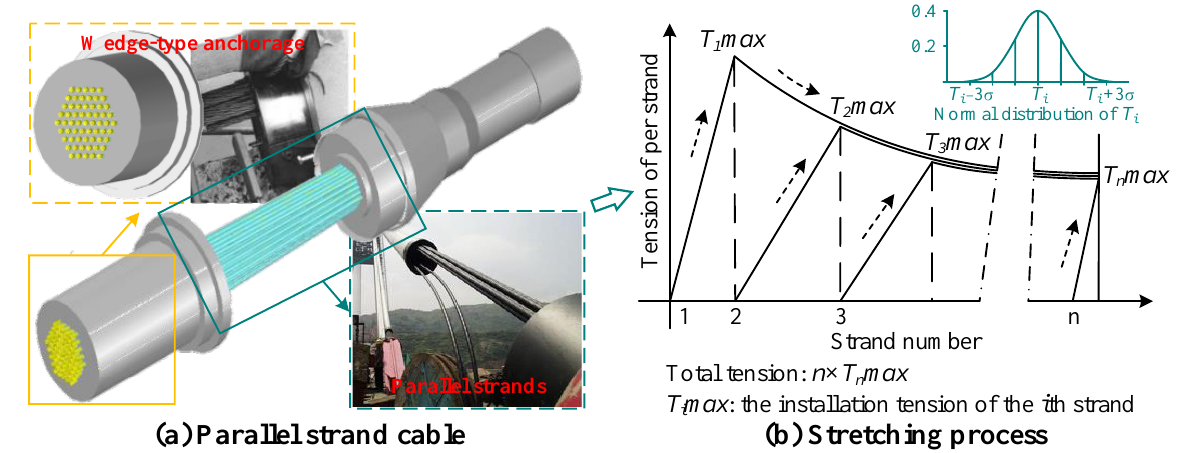
Figure 1. Stretching process of the parallel strand cable.